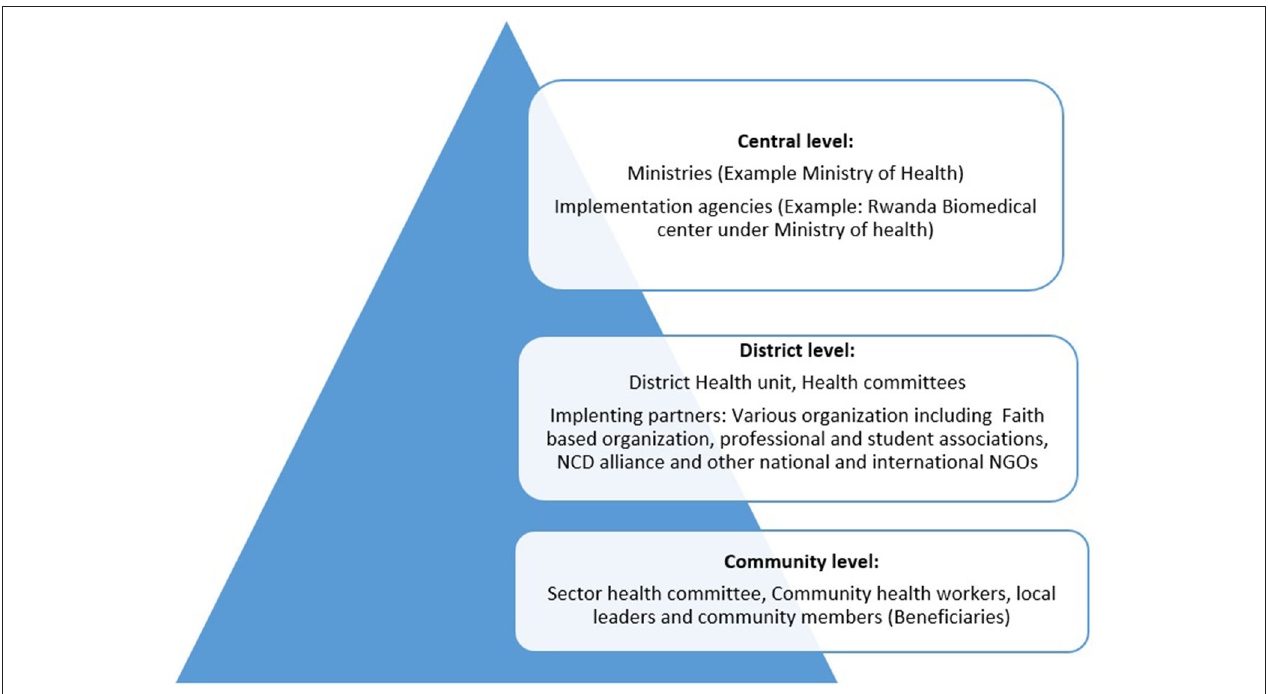
FIGURE 1 | Flowchart of population-level interventions implementation in